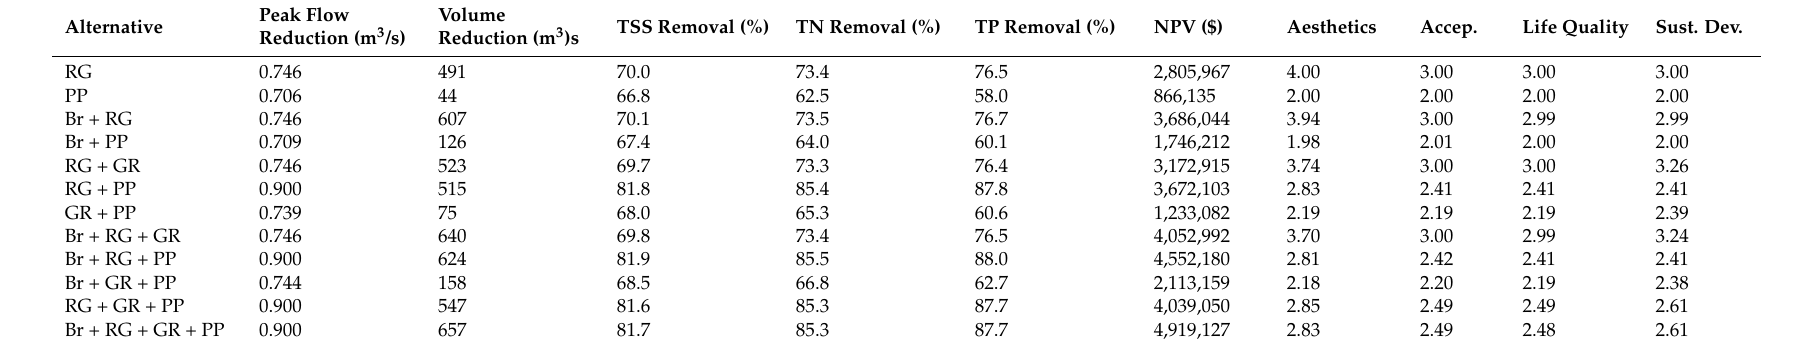
Table 10. General performance